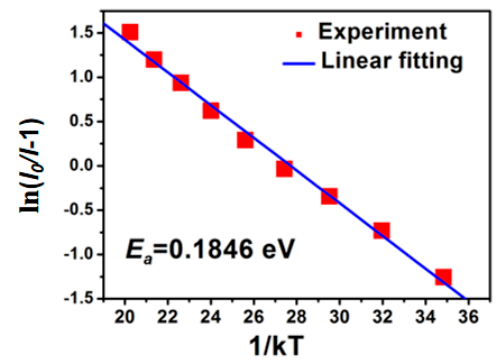
Figure 10. The relationship of the ln( I 0 /I − 1) versus 1/kT for the CTP:0.3Mn 2+ phosphor.